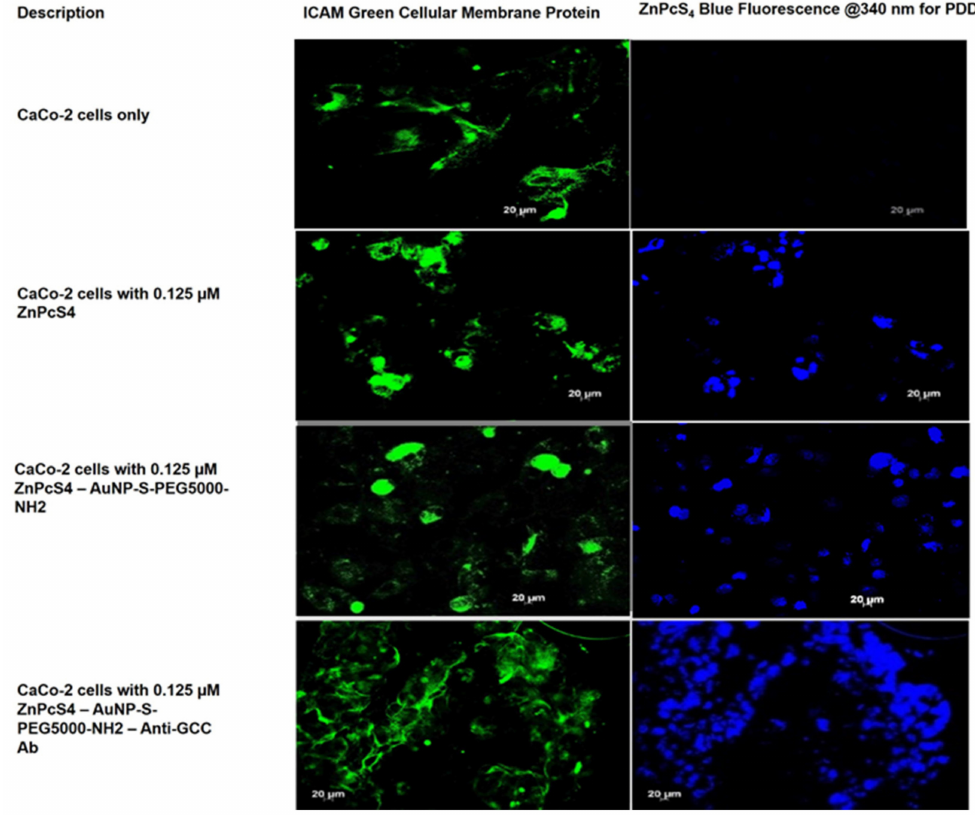
Figure 7. PDD images comparison of ZnPcS 4 PS uptake in CaCo-2 cells, treated with ZnPcS 4 PS alone, AuNP-S-PEG5000- NH 2 -ZnPcS 4 , and the final BNC. Cellular ICAM membrane proteins (green), and ZnPcS 4 PS localization